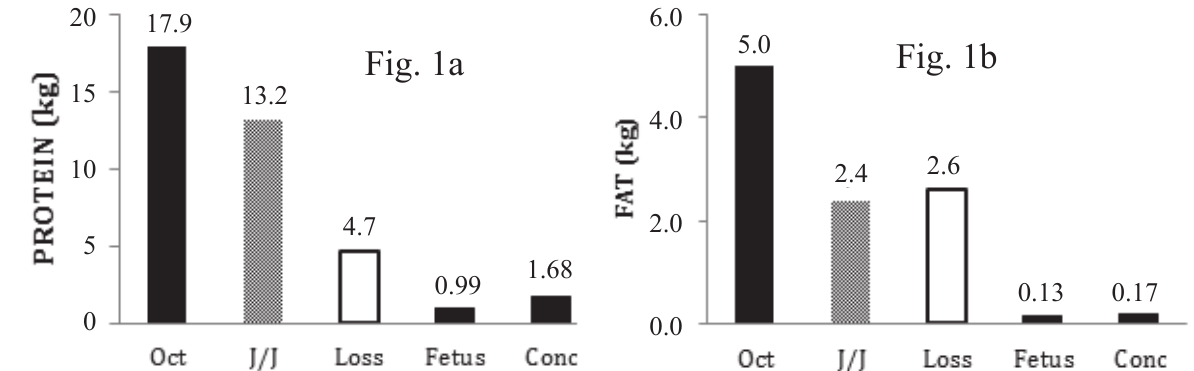
Fig. 1. Mean overwinter loss in body protein (a) and body fat (b) based on body composition measured on females of the Porcupine Herd in October (Oct) and June-July (J/J) (Gerhart et al., 1996). The amount of fetal and conceptus (Conc.) protein (a) and fat (b) were made in the same females in J/J. Note the differences in scales for protein and